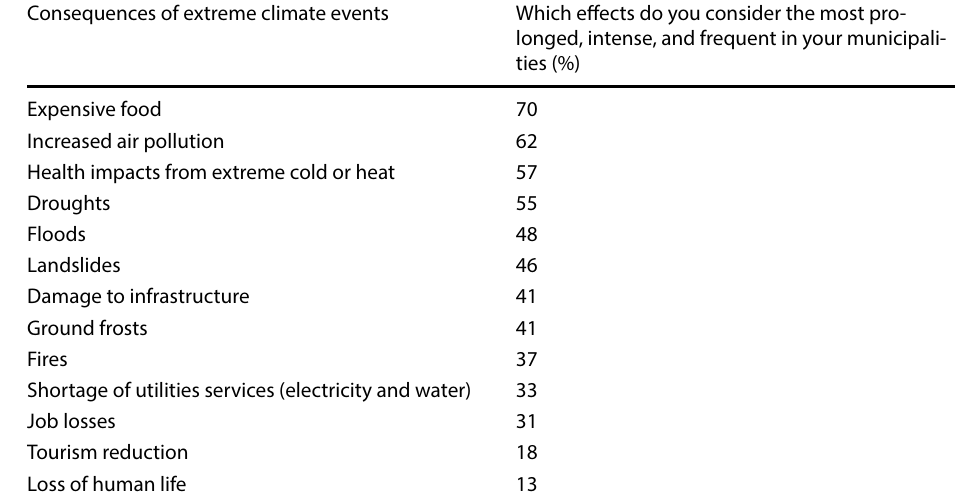
Table 9 Perception on extreme climate events consequences